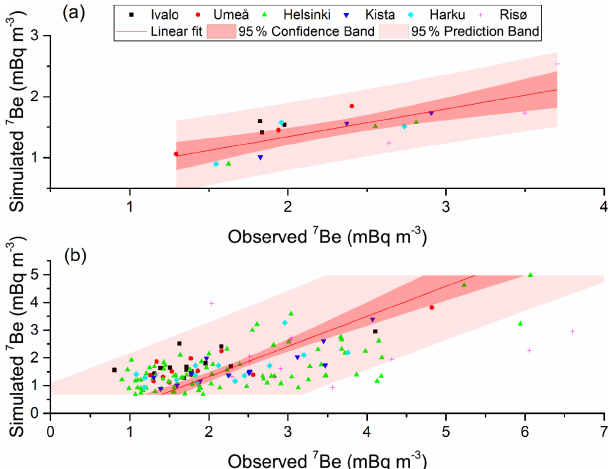
Figure 4. Scatter plots of (a) simulated vs. observed 7 Be monthly means at the six sampling sites and (b) simulated vs. observed 7 Be weekly (daily in the case of Helsinki) means at the six sampling sites. Also shown are the linear regression line and the 95% confi- dence and prediction bands around the linear